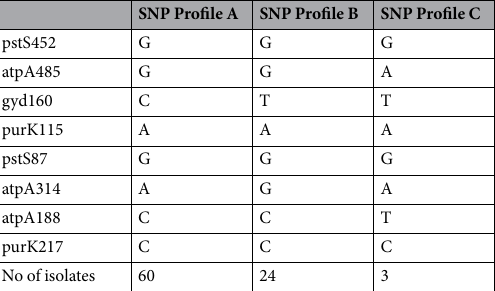
Table 1. SNP site polymorphism used for genotyping of E . faecium 26